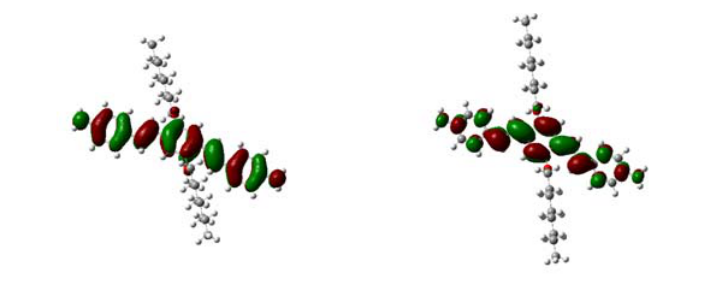
Figure 2. HOMO and LUMO of 6 at the B3LYP/6-31G.